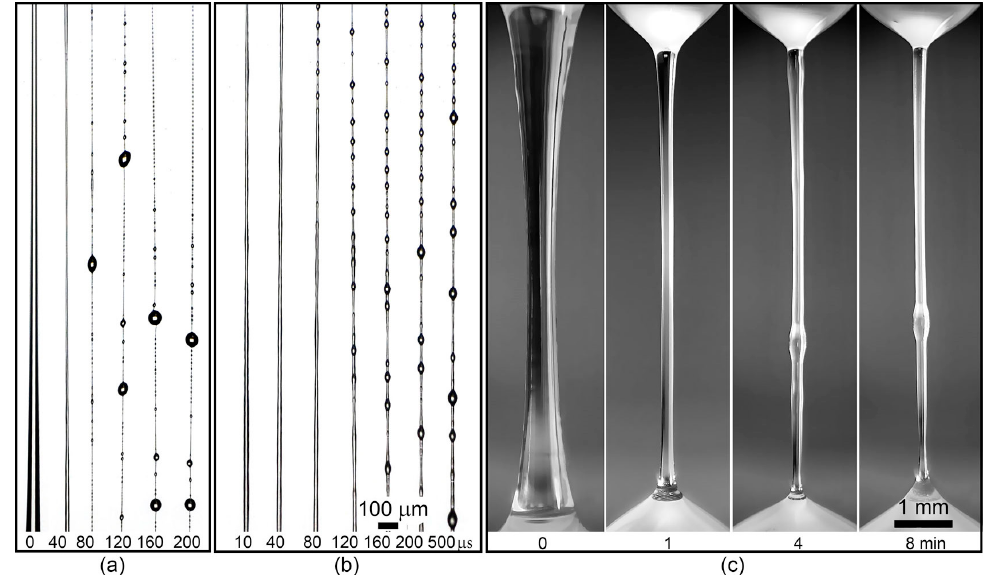
Figure 11. The thinning stages of the A1 copolymer solution drops of different concentrations: ( a )— 10%, ( b )—15%, ( c )—20%.